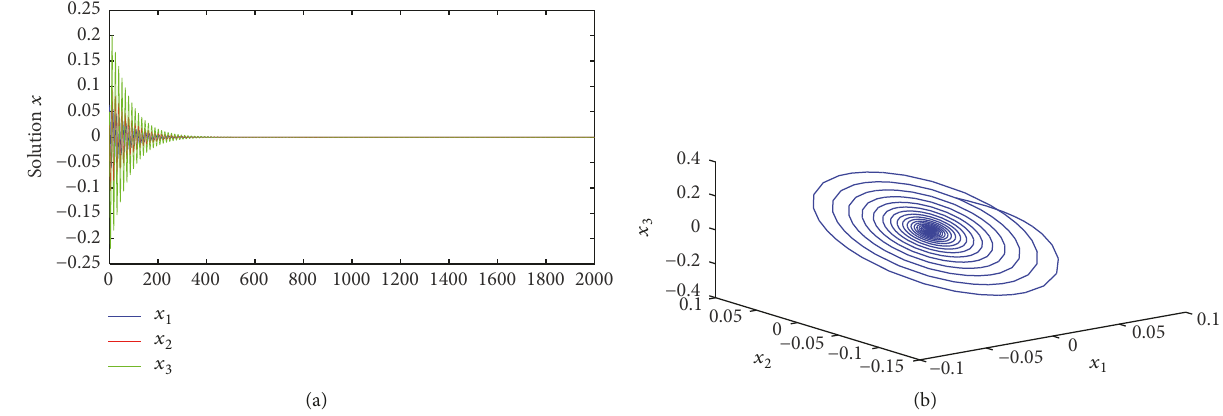
Figure 3: Time waveforms and phase portrait of the PI hydroturbine governing system with the initial value 𝑥 0 = (0.05, 0.05, 0.05), 𝐾 𝐼 < 1.7326 , and 𝜏 = 0 . (a) Time waveforms of 𝑥 2